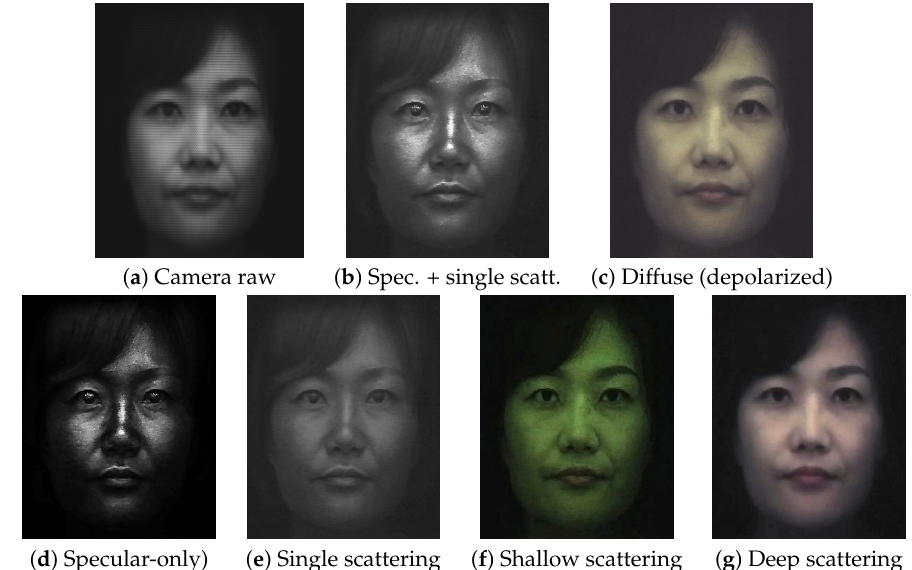
Figure 7. Single-shot layered reflectance separation using the proposed TPLF camera. ( a ) A raw photograph taken by the TPLF camera under uniform (hemi-spherical) illumination (circular microlens pixels visible in the zoomed-in view). ( b , c ) Standard polarization preserving (specular + single scatter) and depolarized (diffuse)reflectancecomponentsseparatedwithlight-fieldsampling. ( d , e )Specular-onlyandsinglescattering further separated from the polarization preserving component ( b ). ( f , g ) Shallow and deep scattering components further separated from diffuse component ( c ). Note that ( d – g ) present results of layered reflectance separation comparable to the multi-shot technique of Ghosh et al. [8] (( c ) Eurographics Association 2016